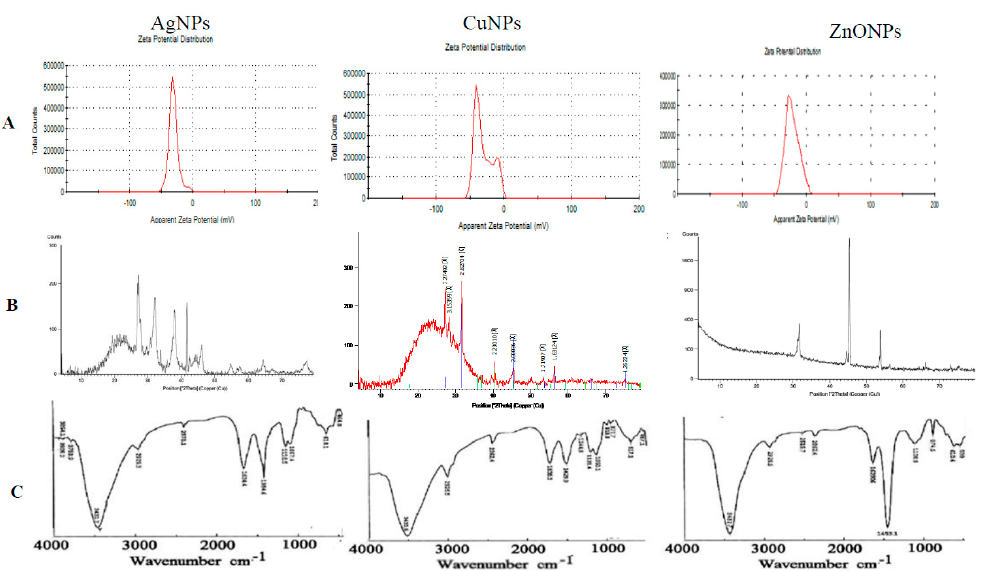
Figure 3. Zeta potential ( ζ -Potential) ( A ), X-ray powder diffraction (XRD) ( B ), and Fourier infrared (FTIR) analyses ( C ) of AgNPs, CuNPs, and ZnONPs synthesized by aqueous extract of Zingiber officinale .